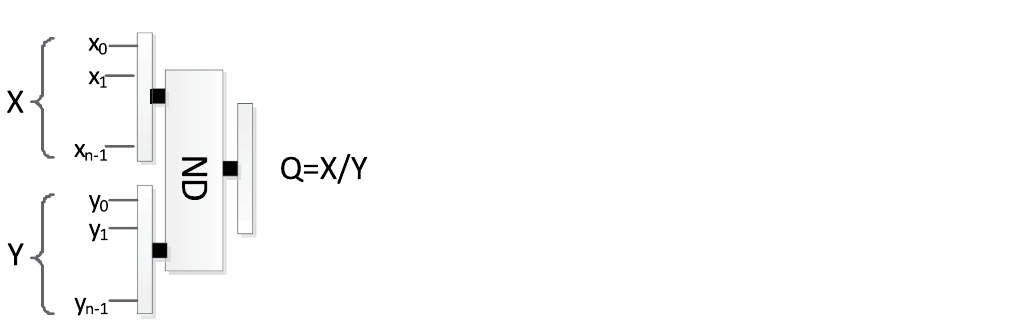
Figure 20. Quantum divider circuit based on restoring division algorithm.